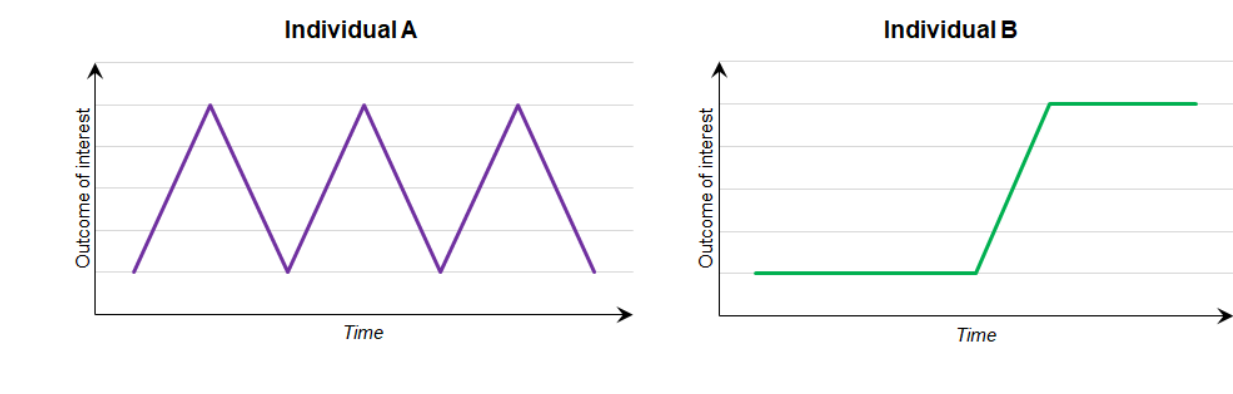
Figure 6. Within-individual repeated observations of an outcome of interest with identical means and SDs but different